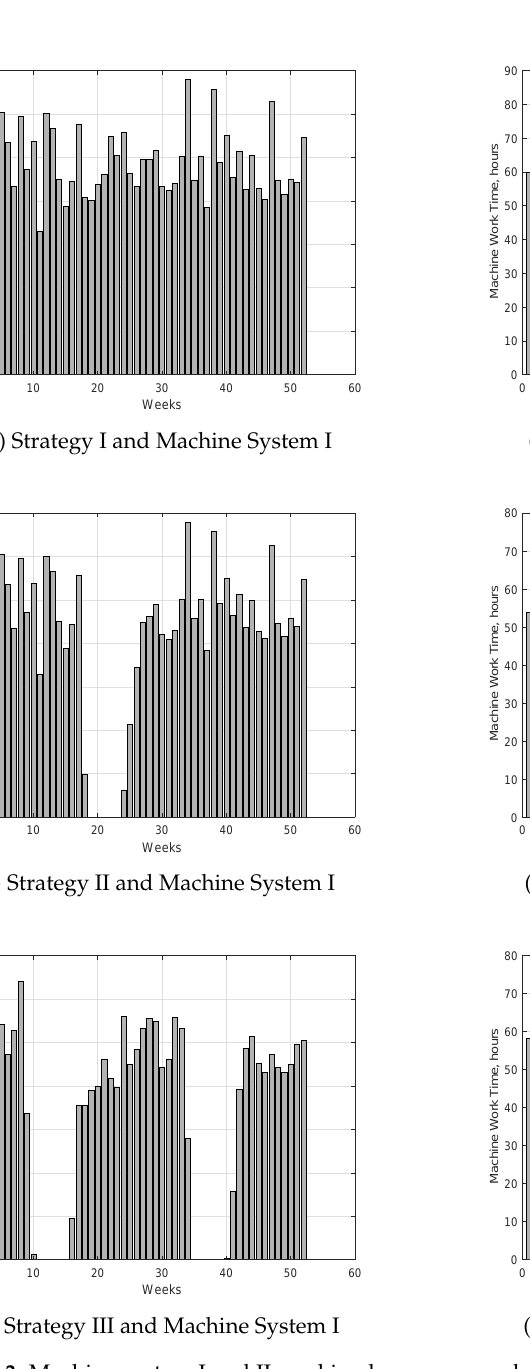
Figure 3. Machine system I and II working hours per week under three different inventory keeping strategies when transporting logs from storage D to storage